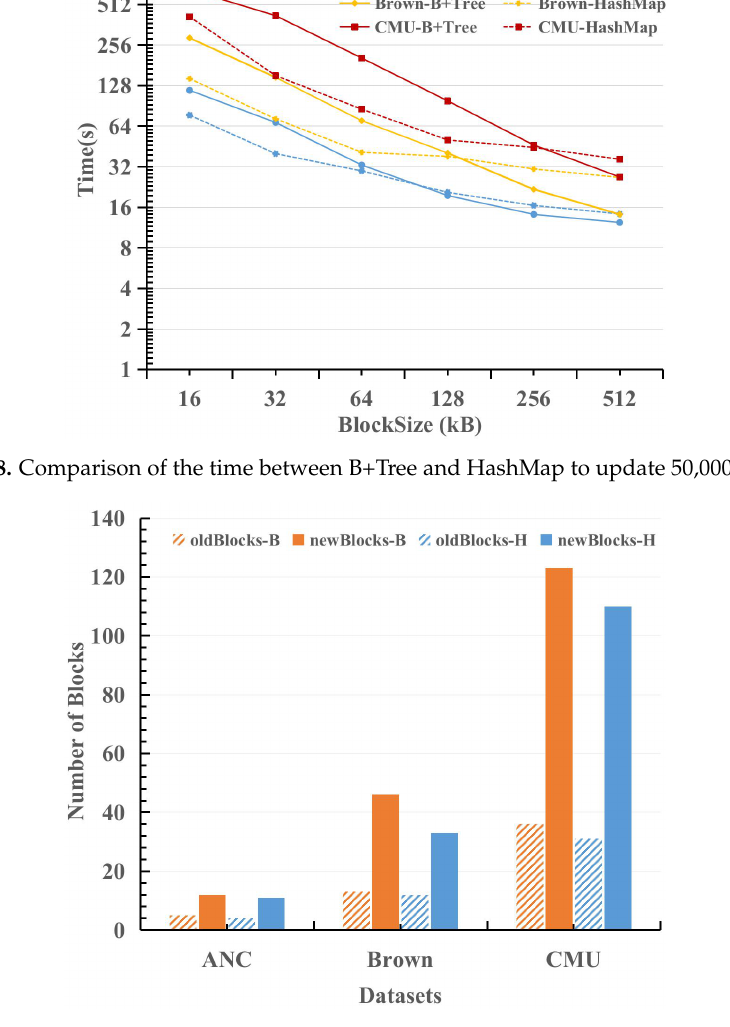
Figure 9. The number of blocks involved in updating 5000 words (256